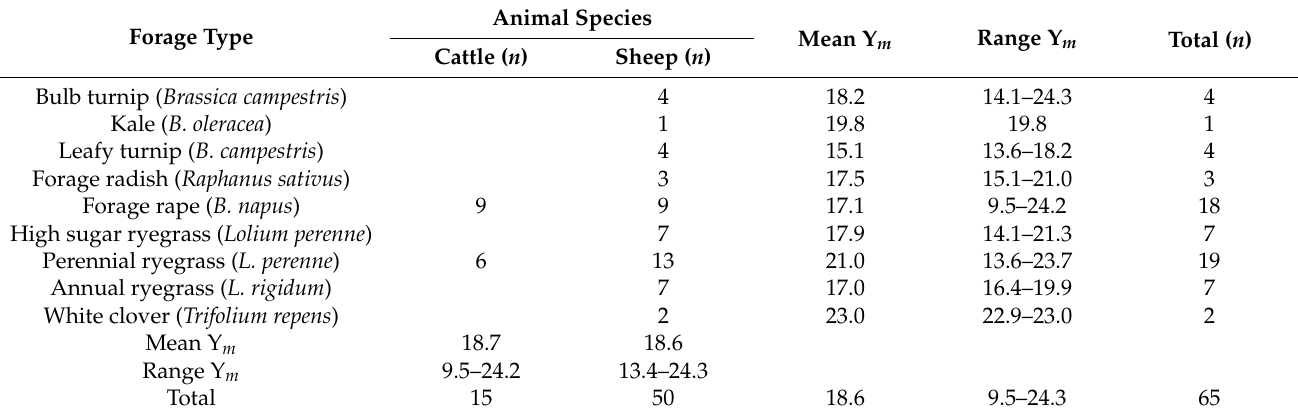
Table 2. Description of the expanded database DB2, showing forage type and animal